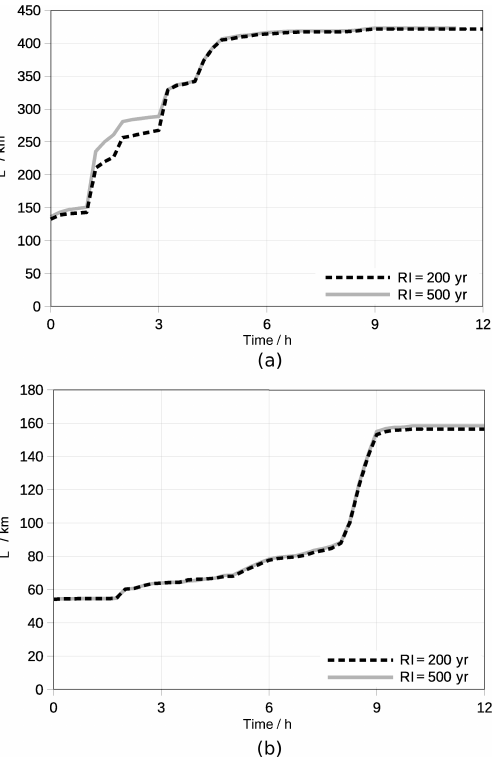
Figure 6. Contaminated pipe length in failure scenario 1 (a) and in failure scenario 2 (b)